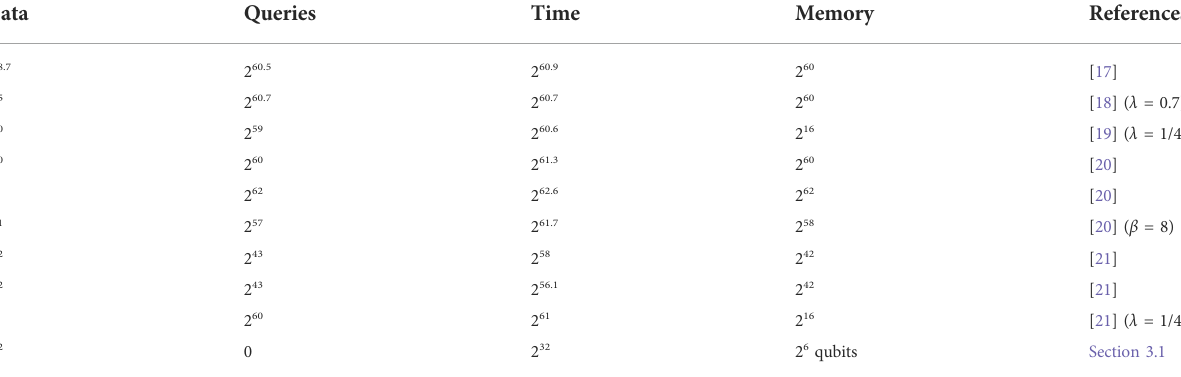
TABLE 2 Comparison of attacks against 2-step LED-64. Assume that one evaluation of the cipher as one complexity unit and the evaluation of one permutation costs 1/2 unit. Data